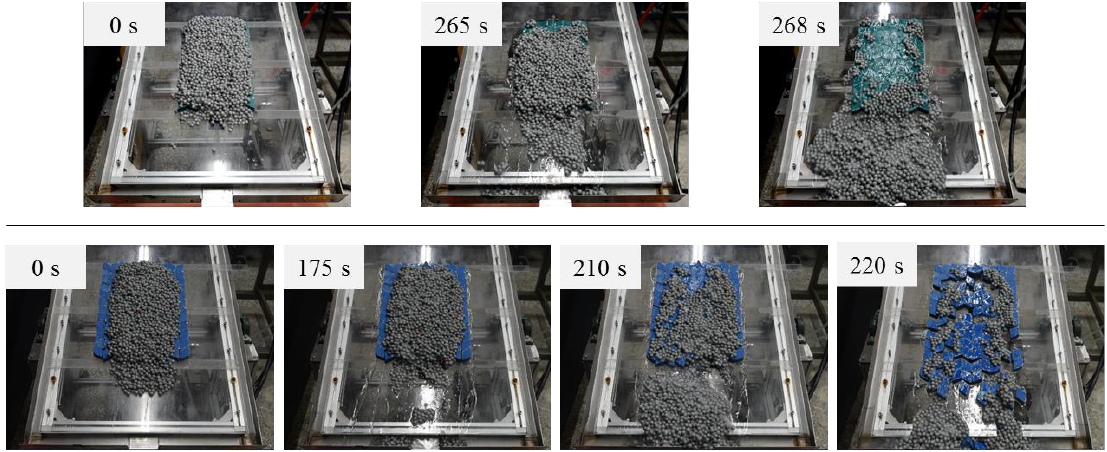
Figure 12. Model 5 ( top ): blocky layer bonded into two larger specimens. Model 6 ( bottom ): grinding stones in blocky layer not bonded together.